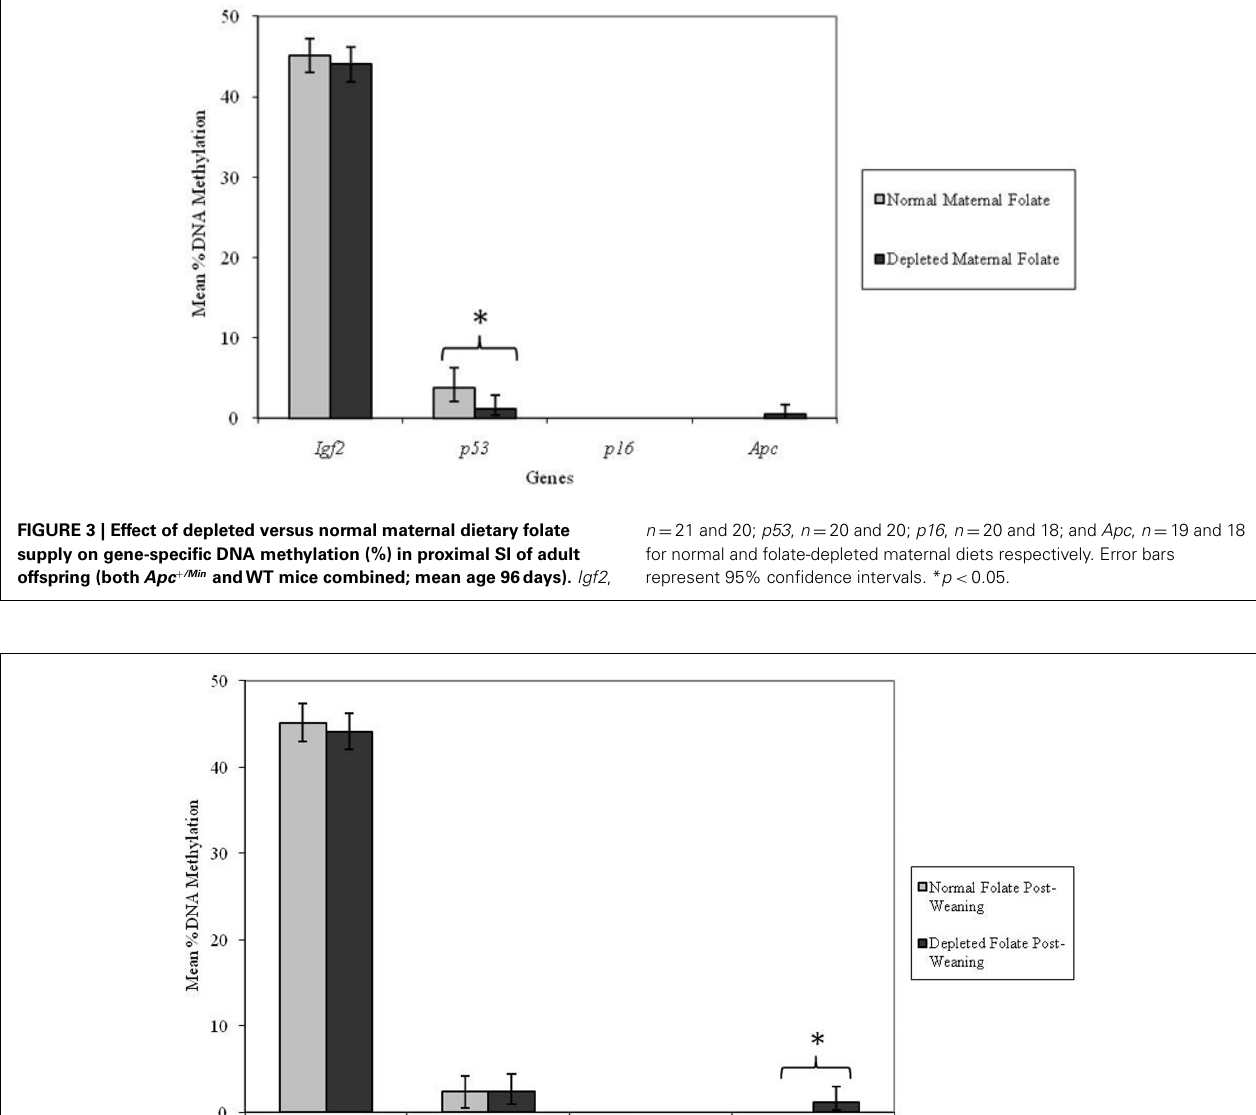
n = 20 and 20; p16 , n = 20 and 18; and Apc , n = 19 and 18 for normal and folate-depleted diets respectively. Error bars represent 95% confidence intervals. * p <